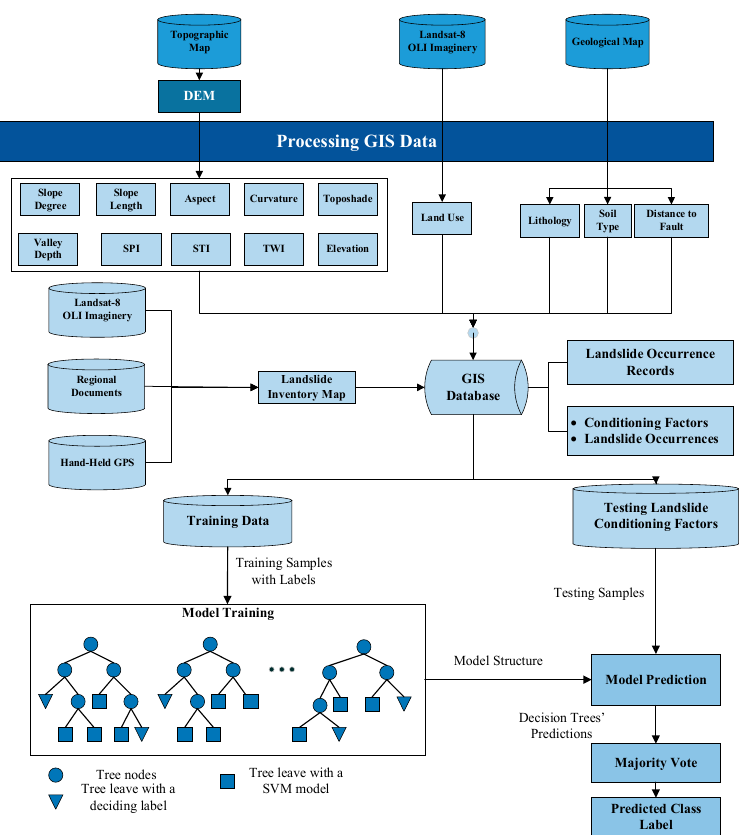
Figure 6. The GIS-based random forest machine for landslide susceptibility prediction.